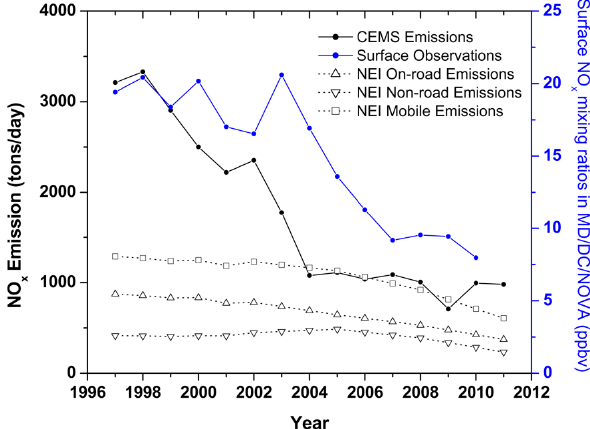
Fig. 5. Long-term trends of annual mean estimated daily emis- sions of NO x (CEMS and yearly NEI in the research domain scaled to more detailed inventories from 2002, 2005, and 2008) and EPA AQS ground-level observations of NO x in the Balti- more/Washington area. NEI mobile emissions are the sum of onroad and nonroad mobile emissions.